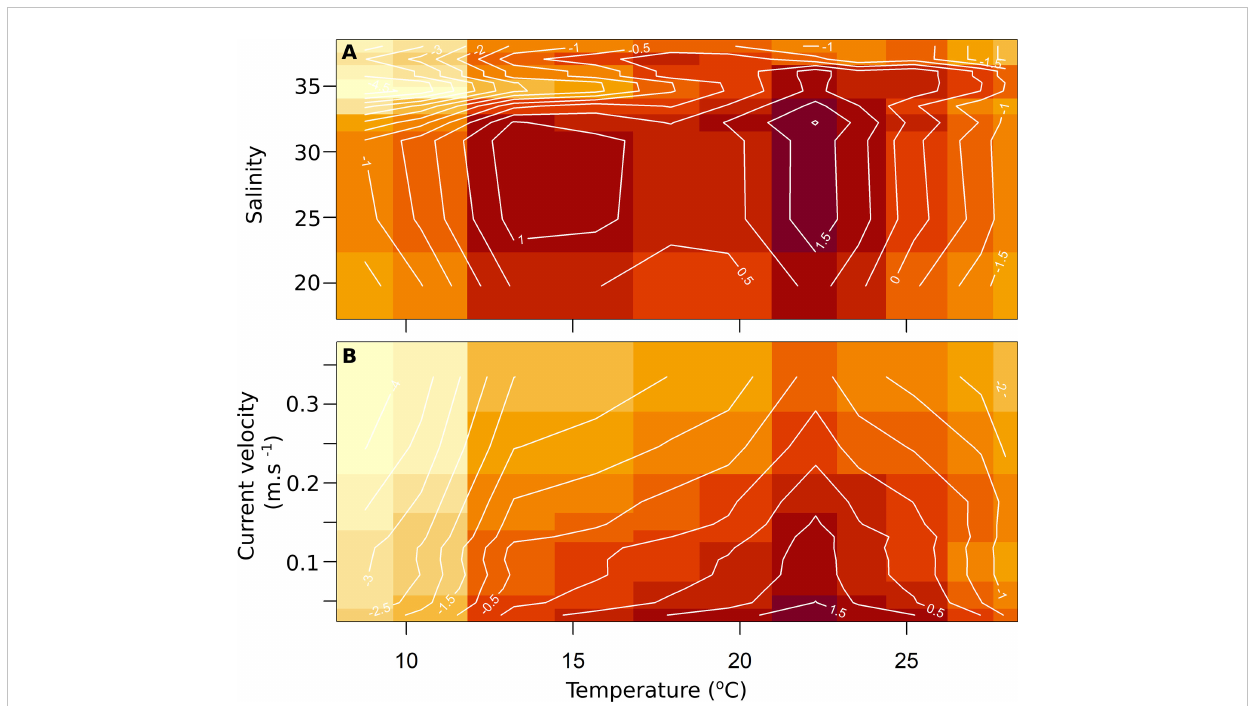
FIGURE 3 Two-dimensional partial dependence plots for the Atlantic blue crab Callinectes sapidus Rathbun, 1896 distribution model. The contour plots show the relationship between temperature and the other covariates in predicting the species distribution, namely salinity (A) , and current velocity (B) . The contour lines represent the posterior median of the f ( x )